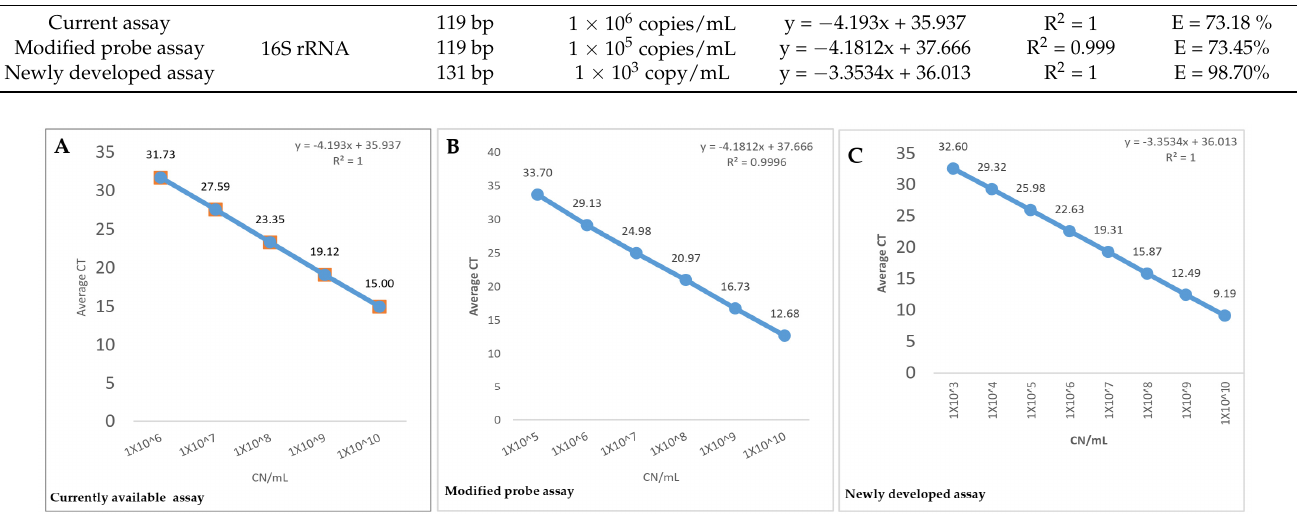
Figure 2. Standard curves of the three qPCR assays included in this study. ( A ): Standard curve of the current qPCR assay was generated by plotting average C T values from three independent runs against log10 of 10-fold serial dilutions (10 10 –10 1 ) of plasmid DNA (copy number/mL). Reaction efficiency of 73.18% was estimated using the standard curve slope. ( B ): Standard curve of the modified probe assay was generated by plotting average C T values from three independent runs against log10 of 10-fold serial dilutions (10 10 –10 1 ) of plasmid DNA (copy number/mL). Reaction efficiency of 73.45% was estimated using the standard curve slope. ( C ): Standard curve of the new qPCR assay was generated by plotting average C T values from three independent runs against log 10 of 10-fold serial dilutions (10 10 –10 1 ) of plasmid DNA (copy number/mL). Reaction efficiency of 98.70% was